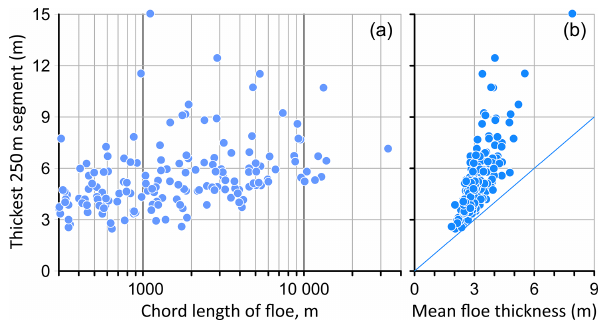
Figure 19. Scatterplot of the maximum 250m averaged thickness of each floe against the measured chord length of that floe (a) and against the mean thickness of the floe (b)